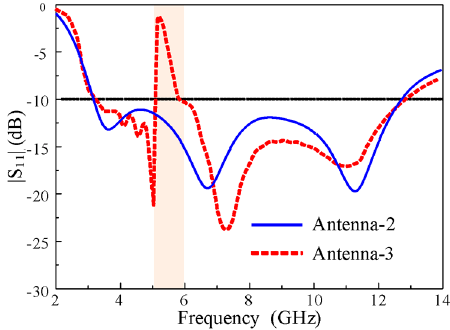
Figure 6. | S 11 | characteristics of Antenna-2 and Antenna-3 Figure 6. |S 11 | characteristics of Antenna-2 and Antenna-3 .